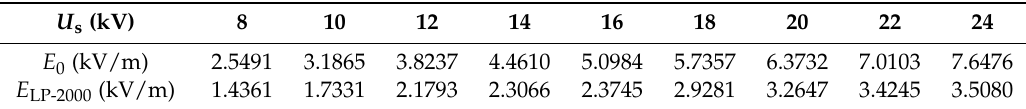
Figure 11. Measuring worksite of Type LP-2000 (in the case of an approaching human body). Table 6. Uncorrected data statistics with different excitation voltages (in the case of an approaching human body).